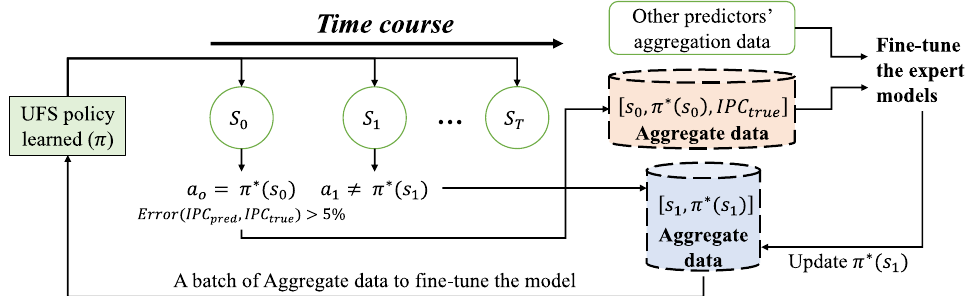
Figure 3. Data Aggregation Framework for Imitation Learning-based UFS policy.